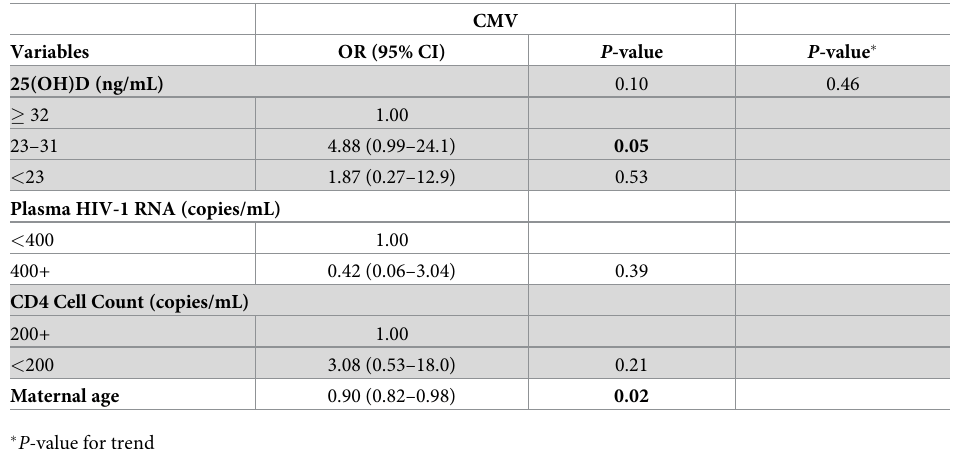
unchanged.[25,34] This increase occurs without impacting serum or urinary calcium levels, hormone axis control.[33,34] Placental trophoblasts and maternal decidua actively convert , in an intracrine manner.[32] Decidual and placental vitamin D to its active form, 1,25(OH)D 2